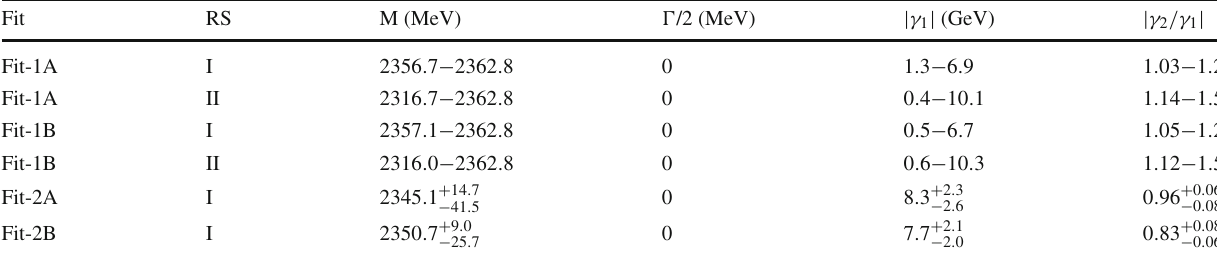
Table 5 Poles and their residues obtained at physical meson masses from the S -wave coupled-channel DK and D s η scattering amplitudes with ( S , I ) = ( 1 , 0 ) . For Fit-1A and Fit-1B, parts of the parameter configurations within one-sigma uncertainties give bound state poles ( 2317 ) and others give virtual poles. In these cases, we sim- for the D ∗ s 0 ply show the ranges for the bound- and virtual-state poles obtained for the parameter configurations from Fit-1A and Fit-1B within one-sigma